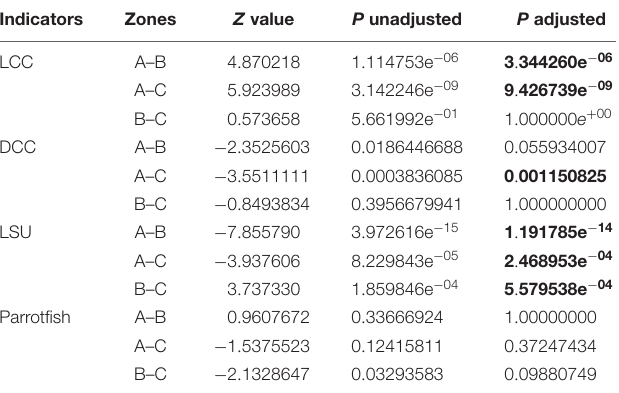
TABLE 1 | Summary of post hoc Dunn test (with Bonferroni adjustment) of three survey components namely live coral cover (LCC), dead coral cover (DCC), parrotfish, long-spined urchins (LSU) comparing between zones A, B, and C.